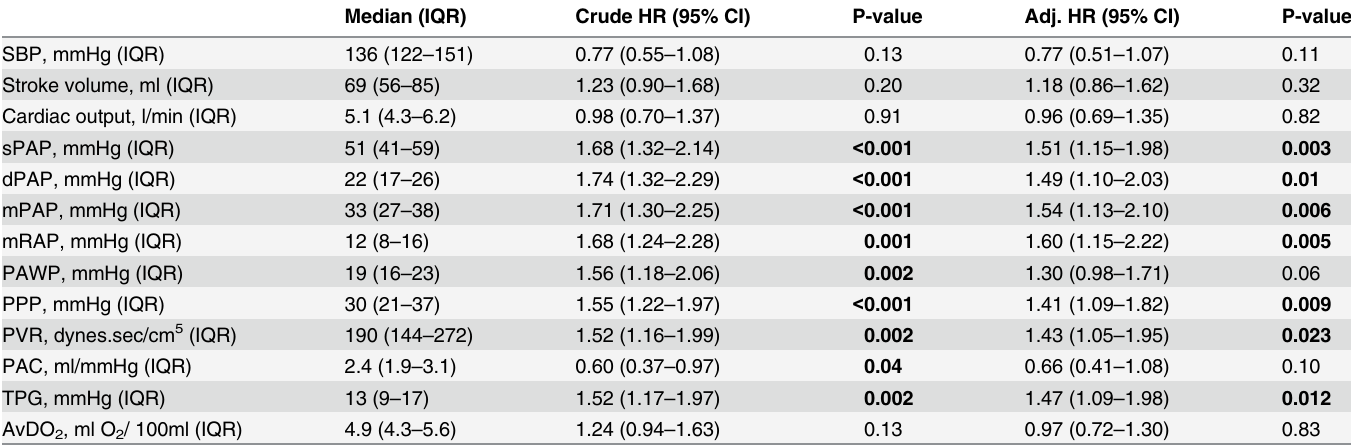
Table 3. Cox proportional hazard models of invasive hemodynamic measurements in patients with HFpEF (n = 142). Hazard ratios (HR) refer to a 1-SD increase in continuous variables. HRs are adjusted (adj.) for all variables in the clinical confounder model i.e. diabetes, COPD, and NT-ProBNP.